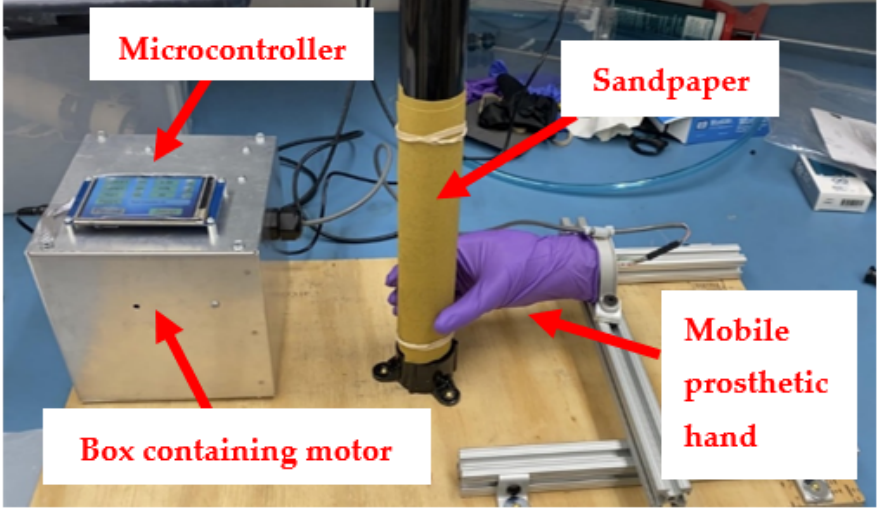
Figure 1. Modified setup of the original glove testing device.